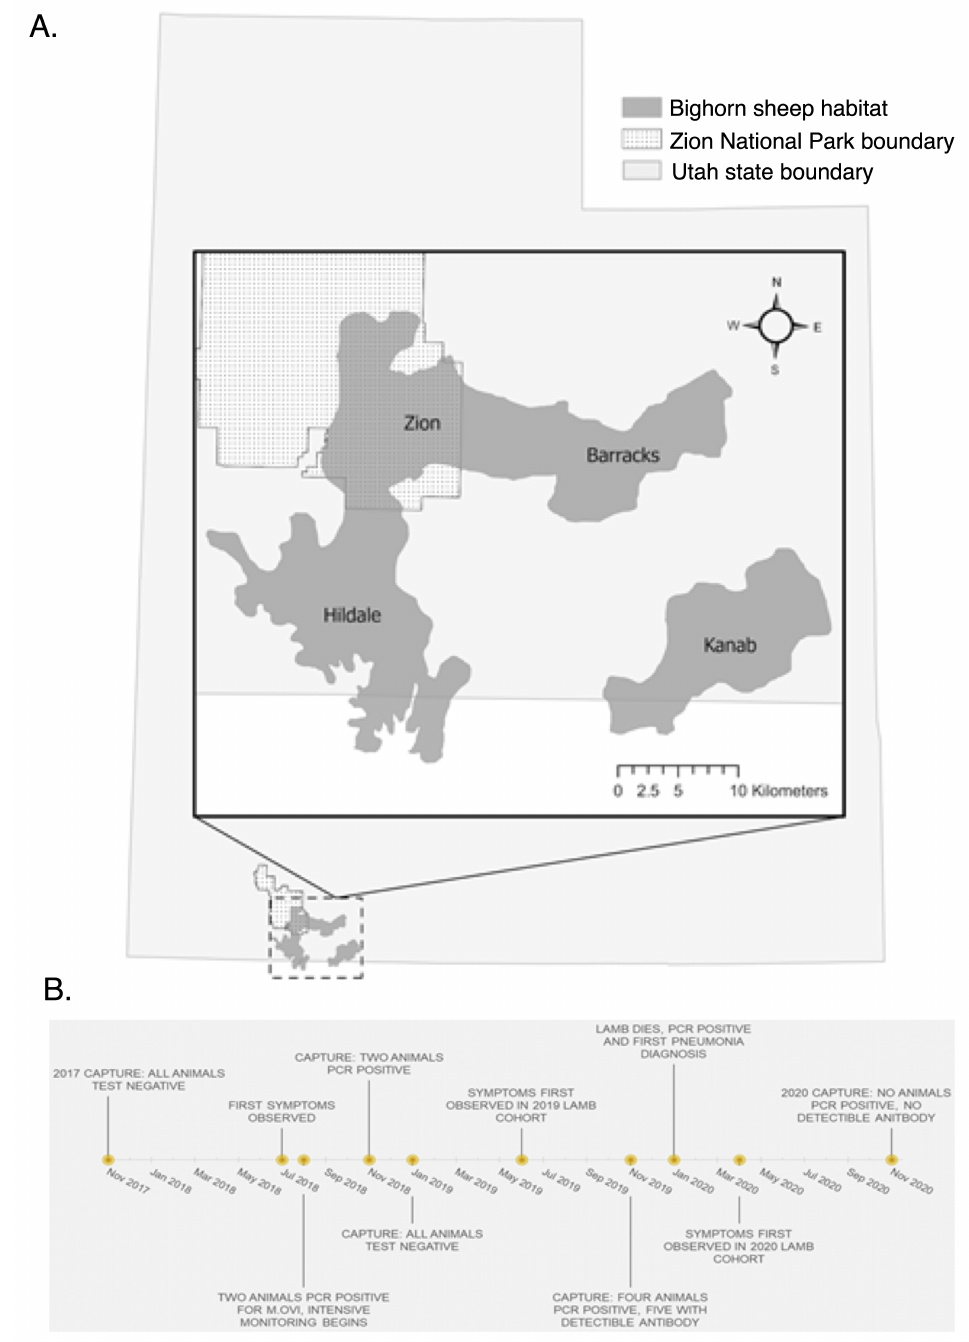
Figure 1. ( A ) Map of Zion bighorn habitat and subunits. ( B ) Timeline of disease events in the Zion